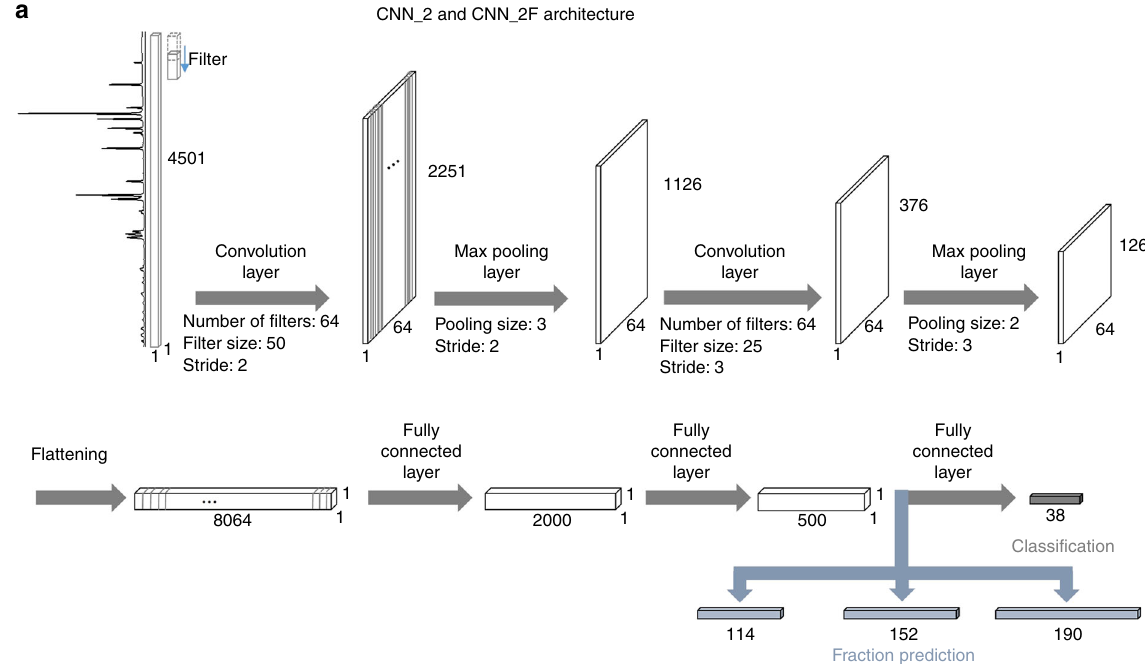
time each of the 800,942 patterns was created. Consequently, whenever a certain compound was detected in many different mixtures, we would see a slightly different peak position (caused by the random selection out of many variants for the compound), a different peak pro fi le, a different background, and a different form of white noise. We never recurrently used only the 38 constituents with fi xed peak pro fi les during the mixture generation process. For example, Al 2 O 3 appeared many times (around ~15,000 times) in 800,942 mixtures, but there was no chance to see the same pattern. Supplementary Fig. 5 shows two synthetic patterns, both of